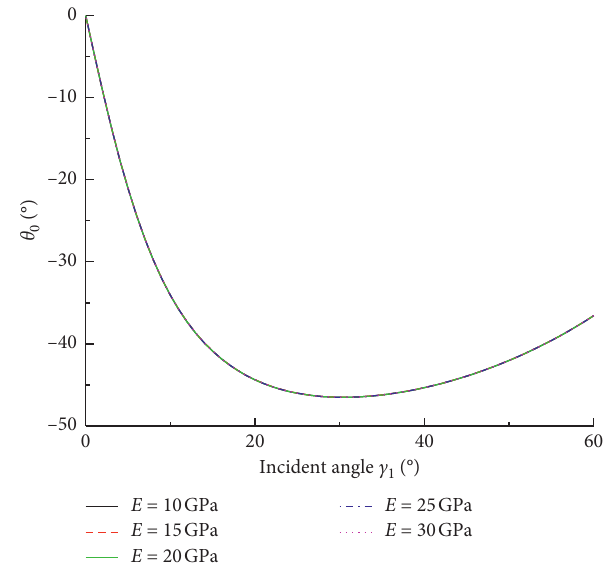
Figure 7: Variation of θ